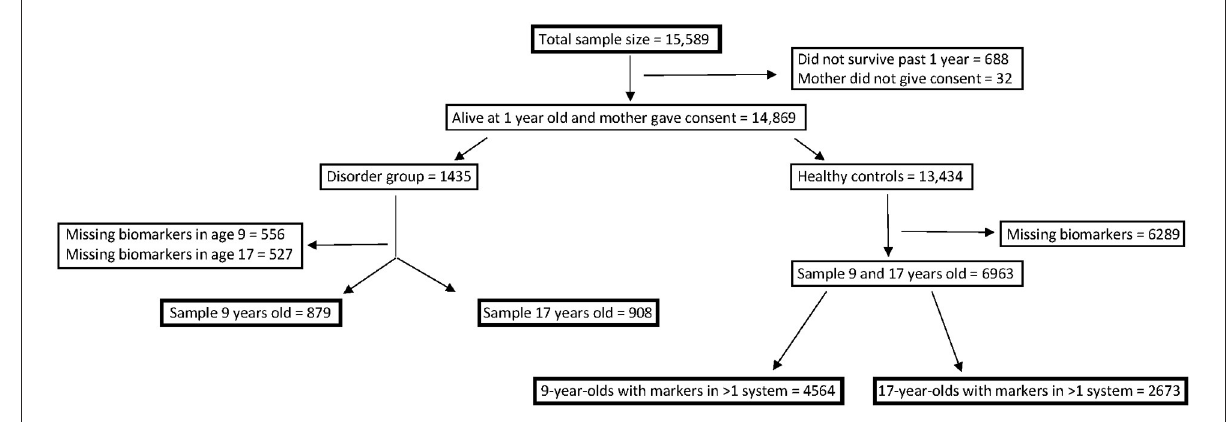
FIGURE1 Process of how sample groups were divided, including exclusion